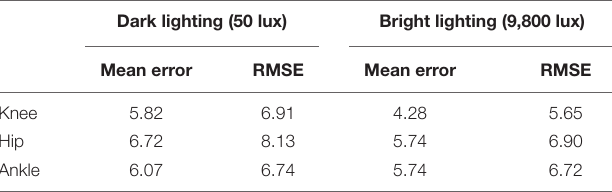
TABLE 2 | Error in joint kinematic measurement with variation in ambient